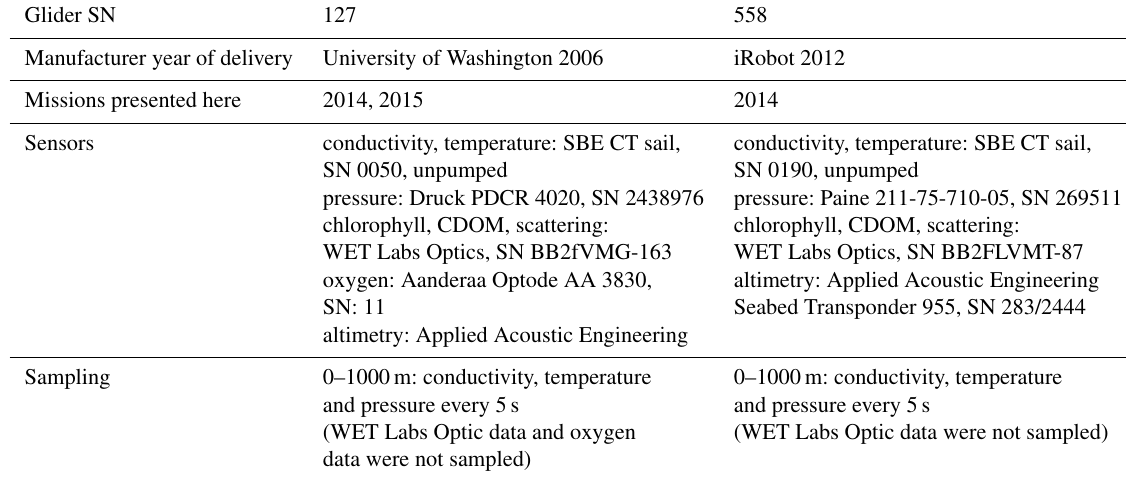
Table 2. Origin of the gliders 127 and 558 and their setup during the two missions in the Greenland Sea in summer 2014 and summer 2015. SN denotes serial number Glider SN 127 558 Manufacturer year of